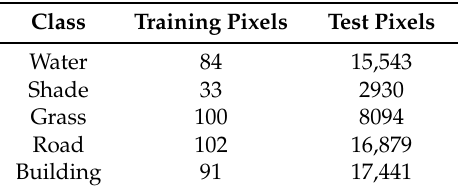
Table 1. Number of training samples and reference data for the aerial image.